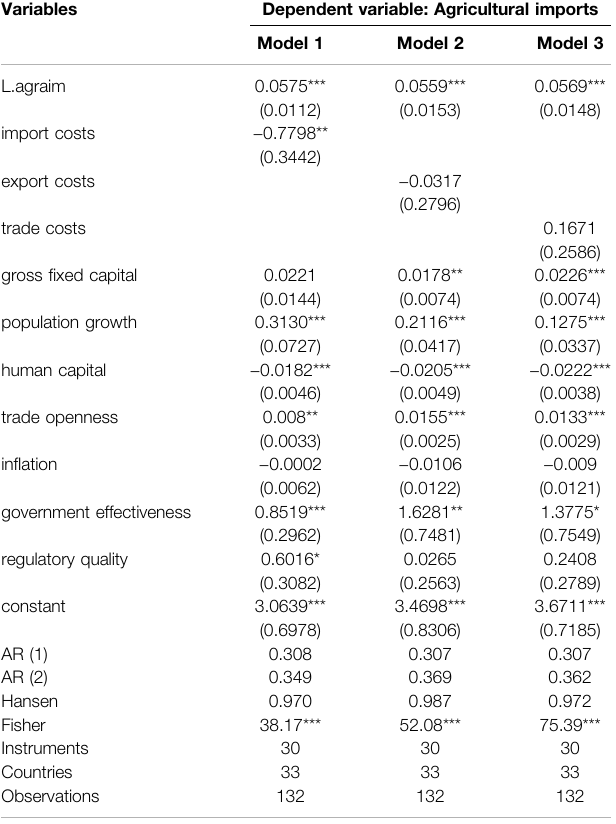
TABLE 6 | Robustness check using agricultural imports (% of merchandise